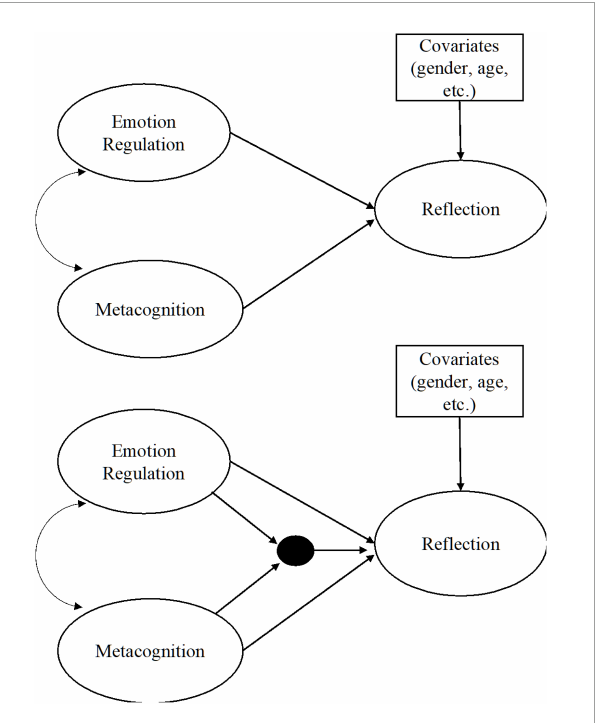
FIGURE2 Structural model of metacognition, emotion regulation, and reflection. (Top panel) represents the baseline model that estimates the main effects of metacognition and emotion regulation on reflection. (Bottom panel) represents the model that estimate the latent interaction between metacognition and emotion regulation on reflection. The black filled circle represents the interaction (see Muthén and Muthén, 2017, p. 84). Covariates included gender, age, GPA, college year, ethnicity, and